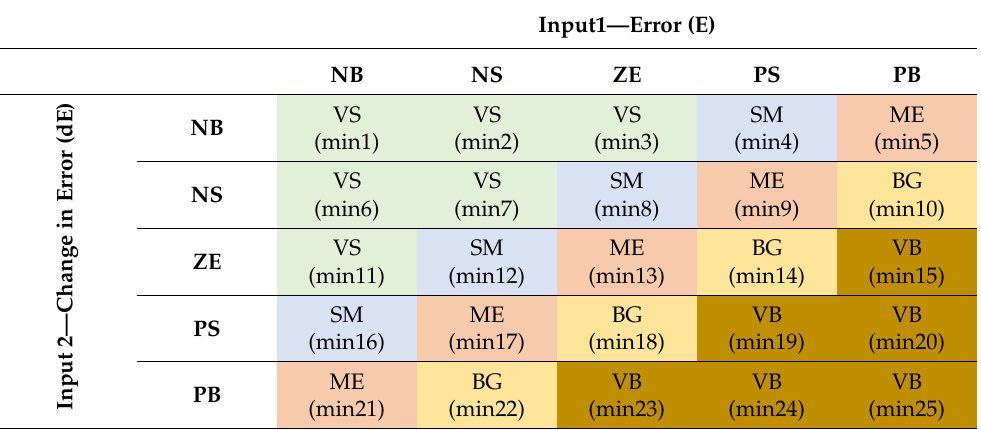
(ME), Big (BG) and Very Big